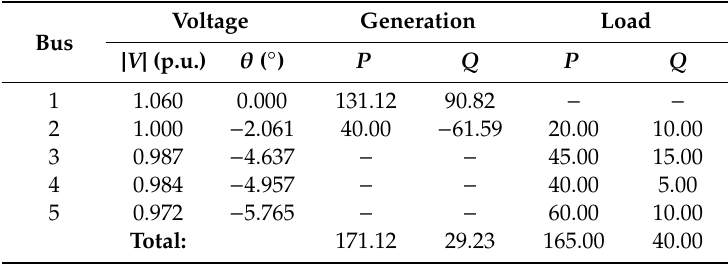
Table A1. Results of AC PF calculations in Case 1. AC bus data.